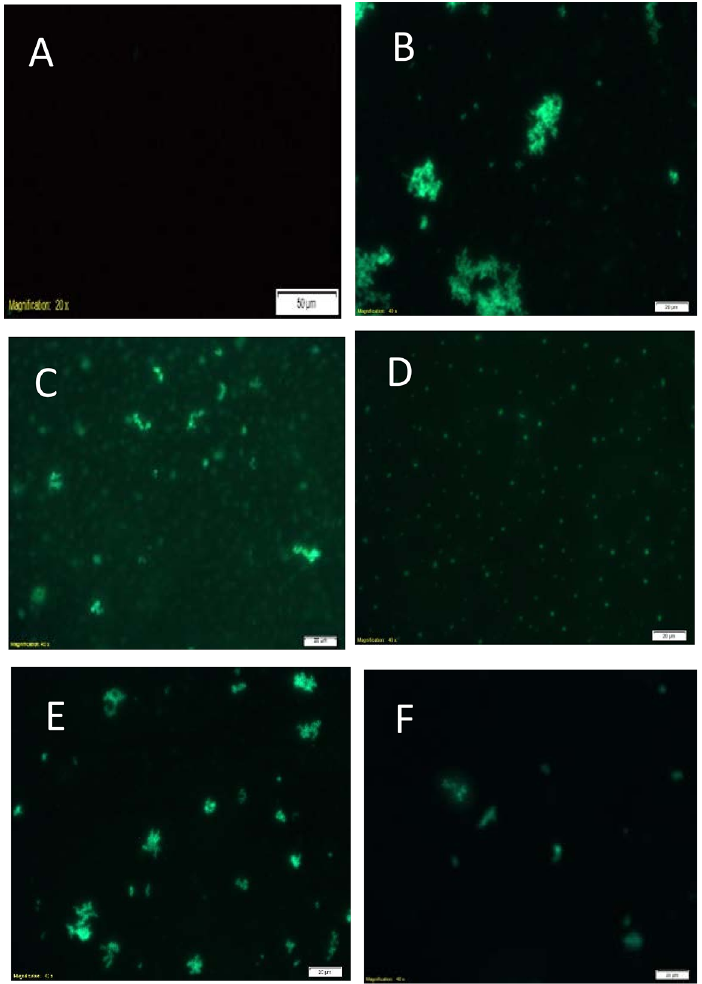
Fig 3. Fluorescence microscopic measurements. (A) HEWL (control) (B) HEWL incubated at 65°C for 120 h (C) HEWL incubated at 65°C for 120 h in presence of 125 μ M PYZ (D) HEWL incubated at 65°C for